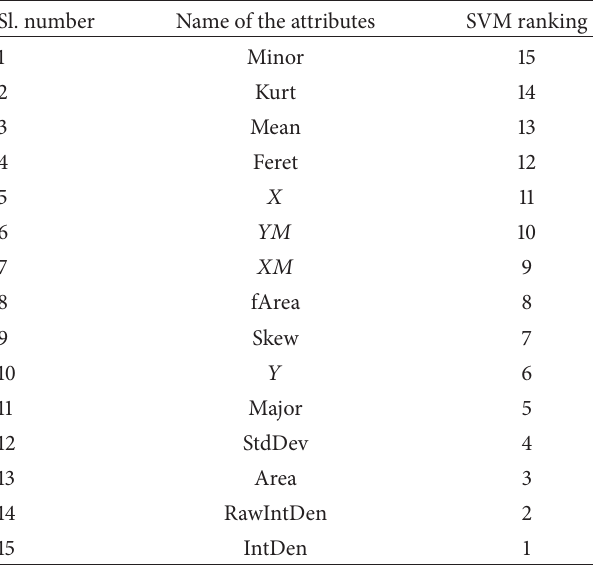
Table 4: SVM ranking table. Sl. number